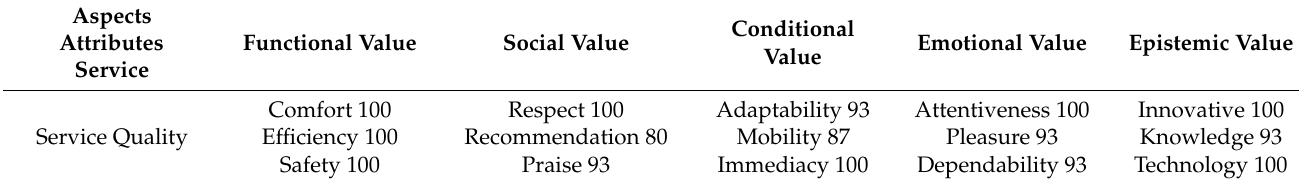
Table 4. CV-SQ attributes classification and consistent data (%).